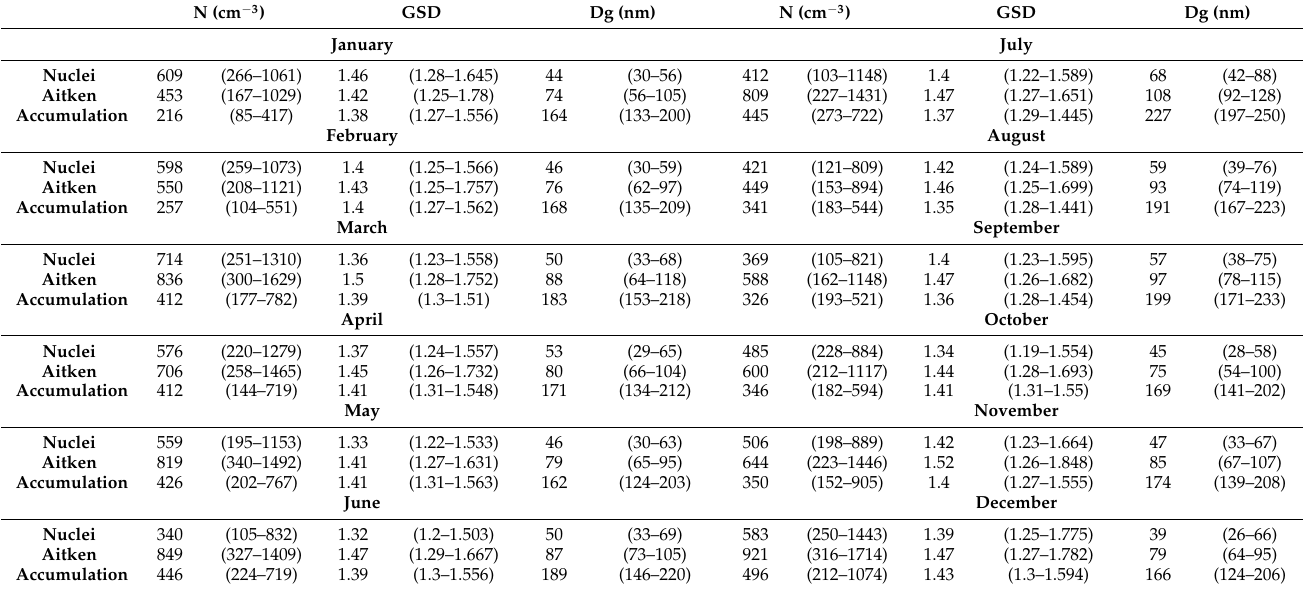
Table A2. Fitted modal parameters for Methoni, December